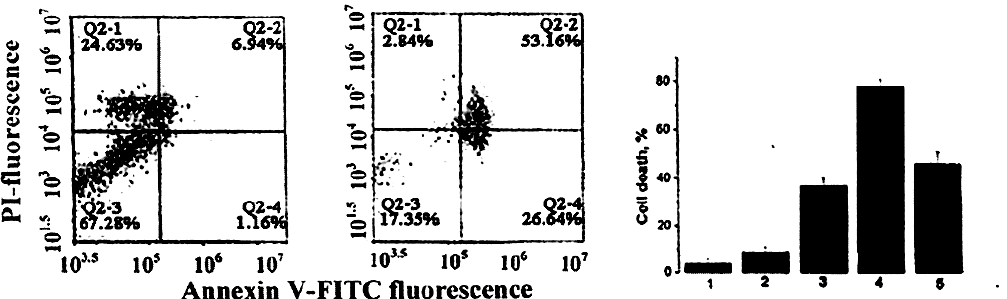
Figure 24. MCF7 cell death in response to the treatment with B-DNIC-MS (0.5 mM) and MGD (1 mM) assessed with Annexin-PI staining. Left panel —2D plots obtained using flow cytometry. Cells were incubated with B-DNIC-MS alone (left plot) and with a mix of B-DNIC-MS andMGD (right plot). Right panel —Mean fraction (%) of dead cells in a suspension. 1—control, 2—B-DNIC-MS, 3—MGD, 4—B-DNIC-MS+MGD (combined action), 5—sum of the effects in 2 + 3 [93]. (With permission).